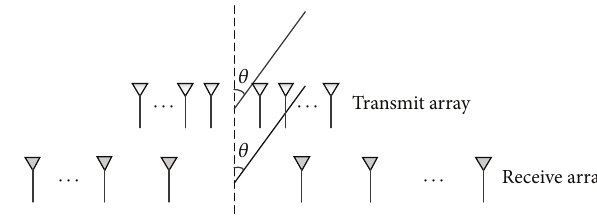
Figure 1: The array structure of monostatic MIMO